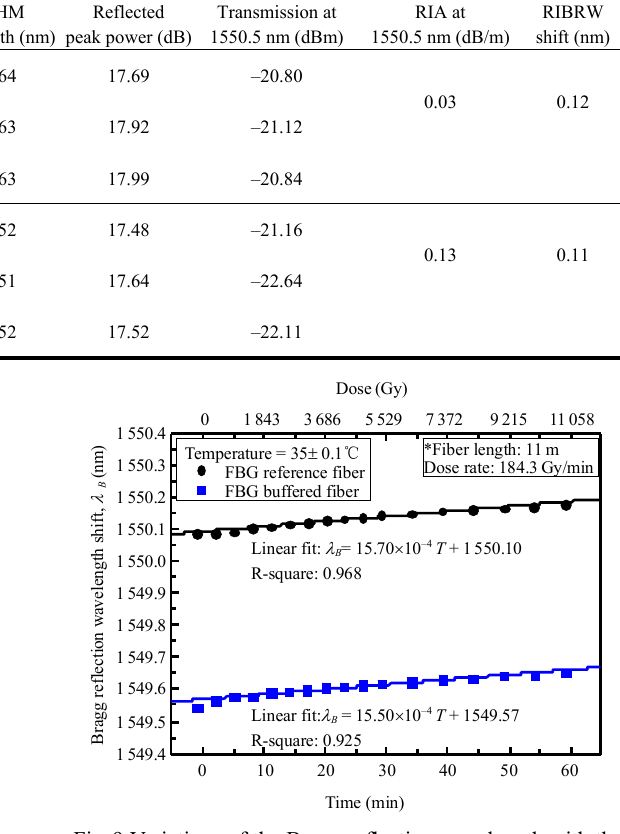
Fig. 9 Variations of the Bragg reflection wavelength with the γ -ray irradiation up to 11 kGy at 35 ℃